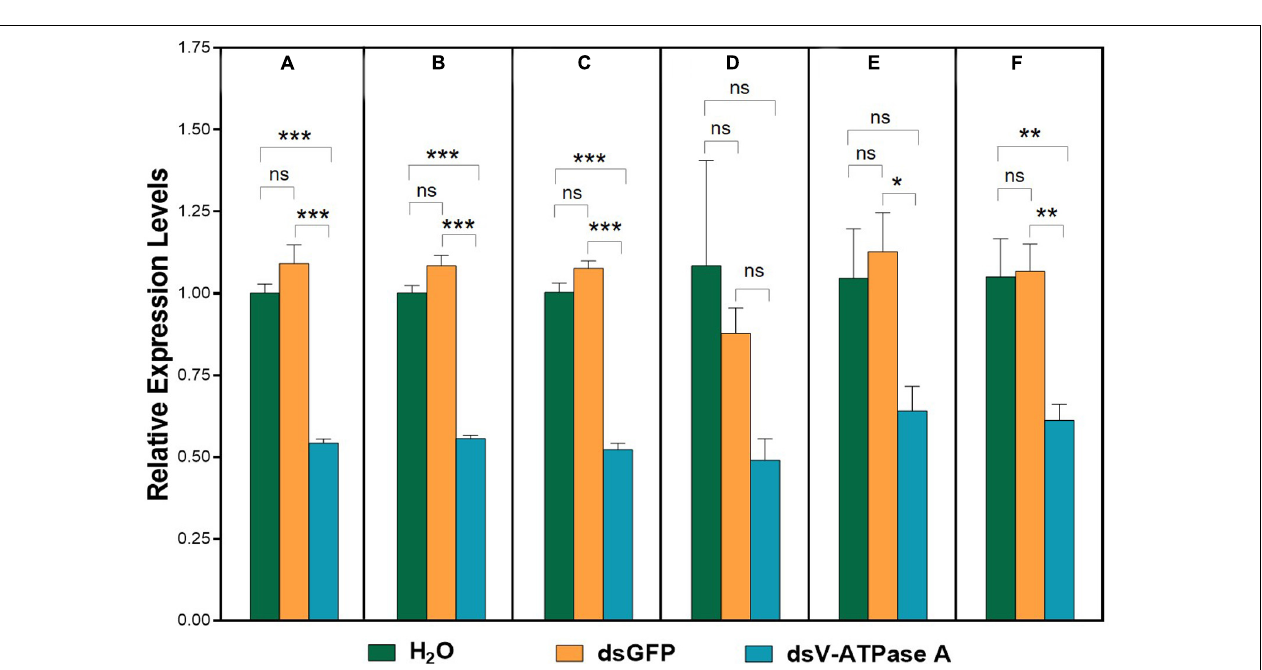
FIGURE 4 | Validation of the recommended reference gene(s). Expression profiles of V-ATPase A under dsRNA treatments were investigated using six normalization factors. V-ATPase A expression levels were analyzed when normalization for the most suited ( GAPDH ) (A) , the top two most suited ( GAPDH , V-ATPase B ) (B) , the top three most suited ( GAPDH , V-ATPase B , RPS9 ) (C) , the least suited ( β -actin ) (D) , and the top two least suited ( β -actin , 18S ) (E) , and the top three least suited reference genes ( β -actin , 18S , 28S ) (F) . Bars represent the means l’ standard error of three biological replicates. Asterisk indicate significant differences between the treatments and controls (*** P < 0.001, ** P < 0.01, * P < 0.05, ns indicate no significant difference).